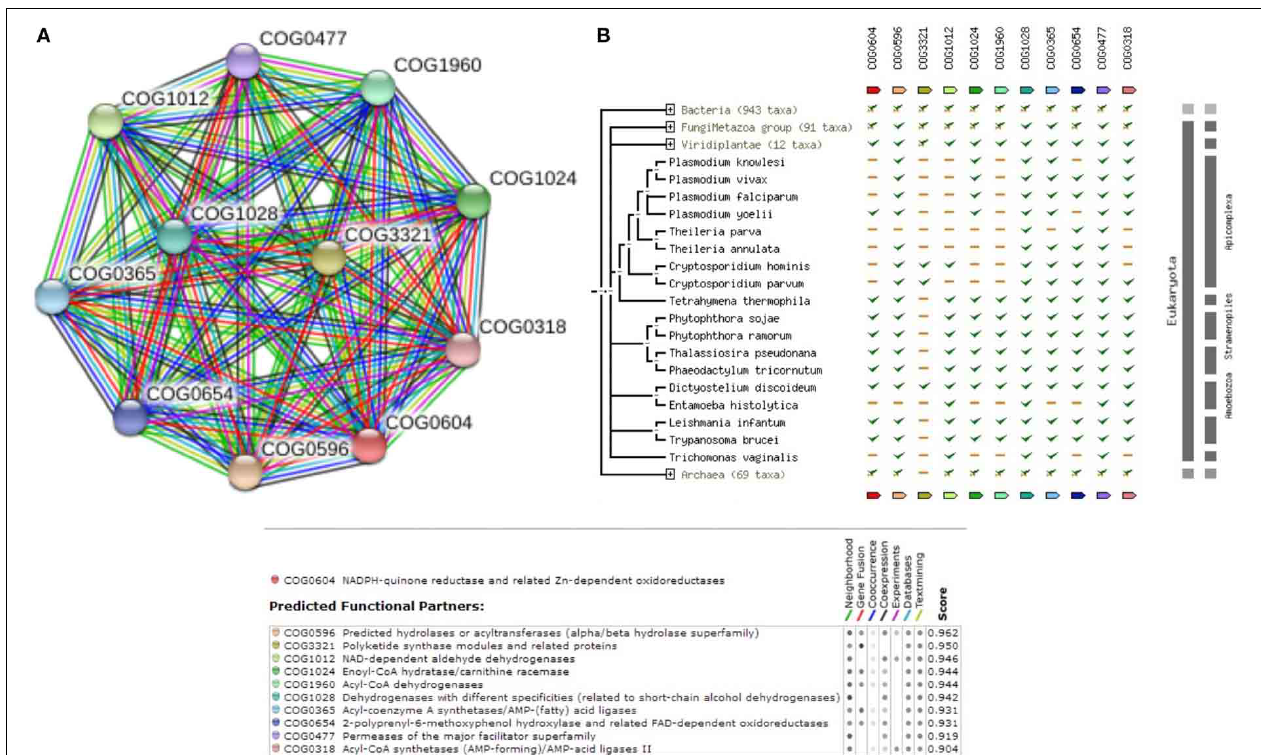
FIGURE 5 | (A) COG network display for members of Fatty Acid Elongation (Mitochondria) Pathway. (B) Phylogenetic profile of the members of Fatty Acid Elongation (Mitochondria)